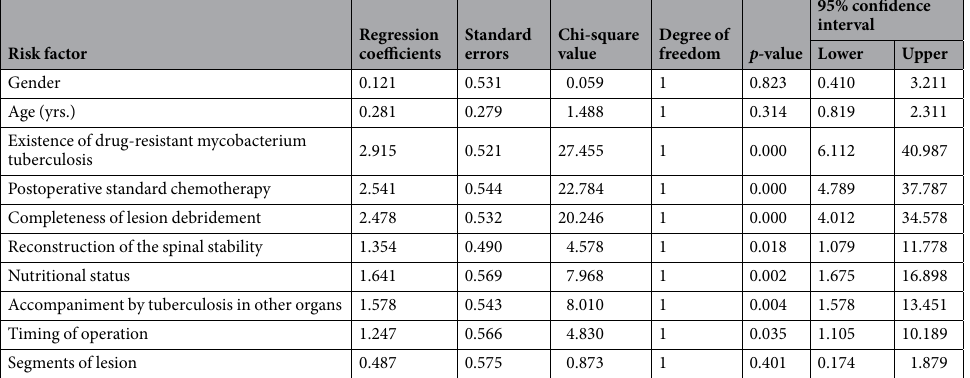
Table 3. The single factor Logistic regression analysis results of the reasons for recurrent complex spinal tuberculosis accompanied with sinus tract formation.